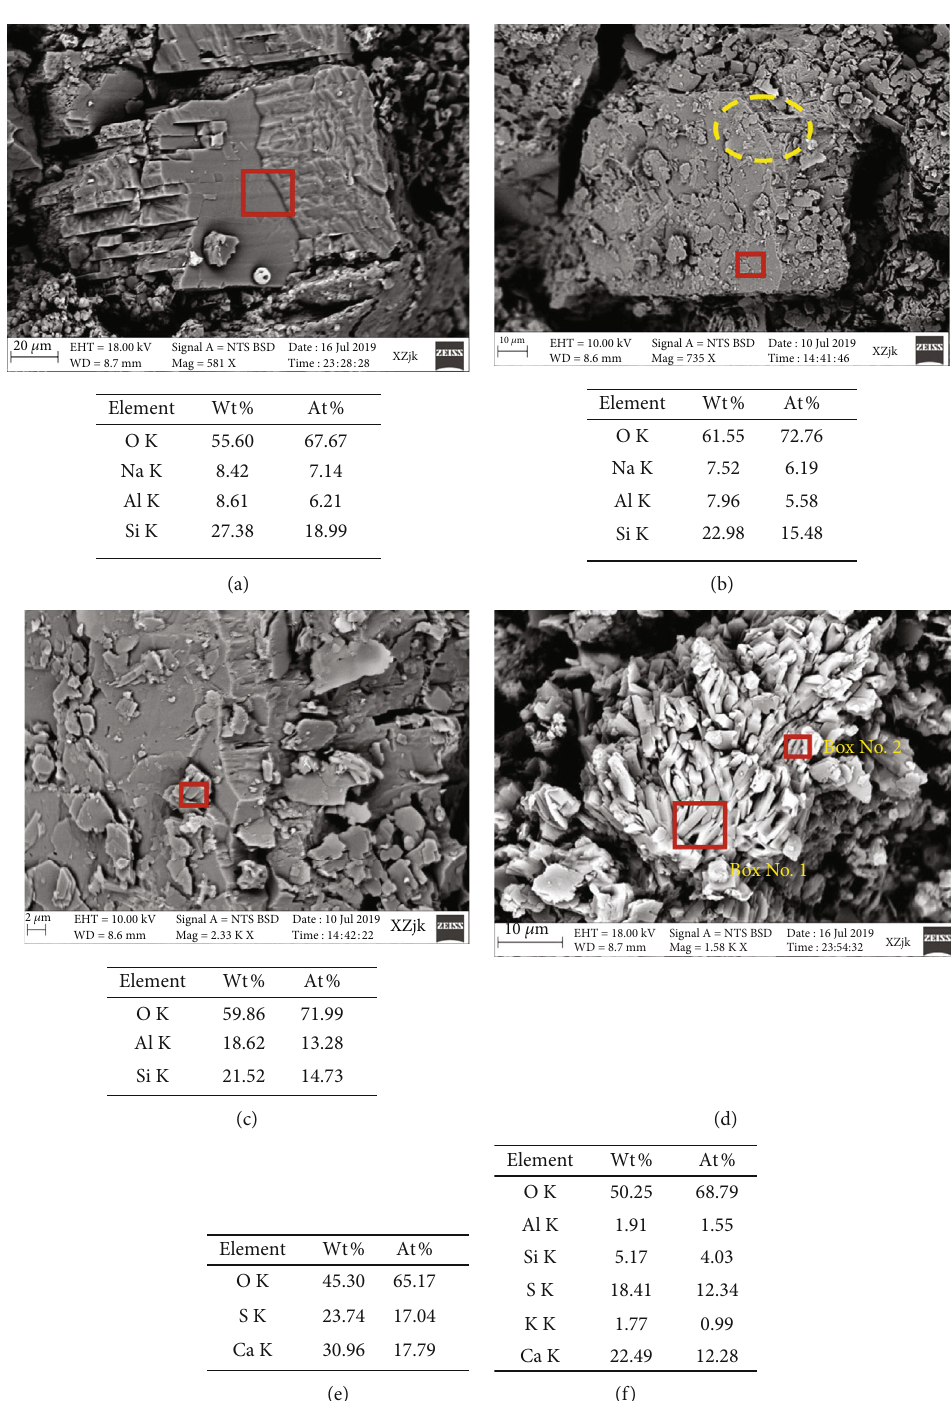
Figure 7: Microstructures of fracture-surface feldspars in the fi ne-grained sandrock specimen before and after the experiment and secondary sediments formed on the feldspar surfaces. (a) Albite crystals (before the experiment). (b) Corroded albite crystals (after the experiment). (c) Local zoom of the ellipse marking area in (b). (d) Secondary CaSO crystals on the fracture surface. (e) EDS analysis in the No. 1 box of (d). (f) 4 EDS analysis in the No. 2 box of